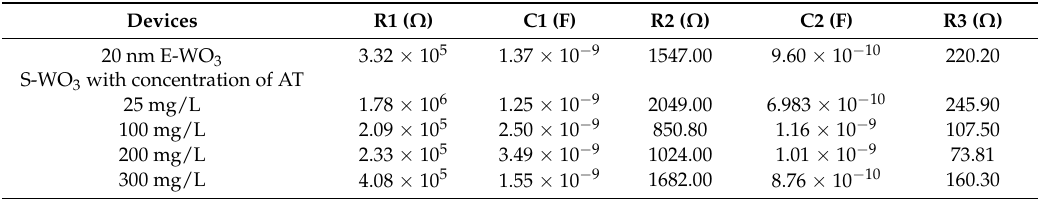
Figure 5. ( a ) Equivalent circuit model of the devices. (R1 and CPE1, R2 and C2, R3 represent equivalent of donor and accepter interface, interface between active layer and electrodes, resistance of electrodes, respectively; ( b ) Cole–Cole plots of the devices based on E-WO 3 and S-WO 3 films with different precursor concentration. Table 2. Parameters employed for the fitting of the impedance spectra by using an equivalent circuit model.